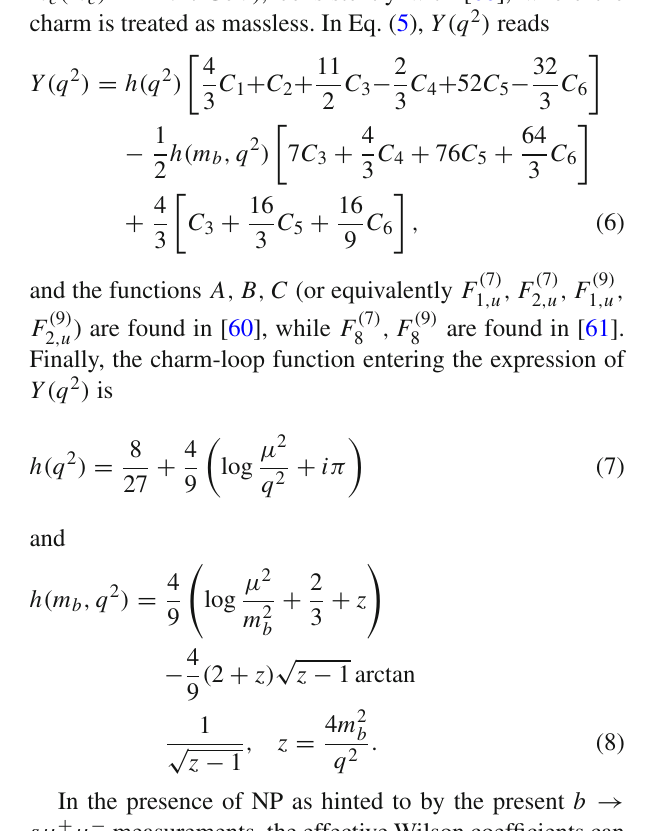
Table1 SMWilsoncoefficientsintheMS(NDR)schemeatthescale μ b = 4 . 8GeV,Refs.[53–58].Below ˜ C 7 ≡ C 7 − 1